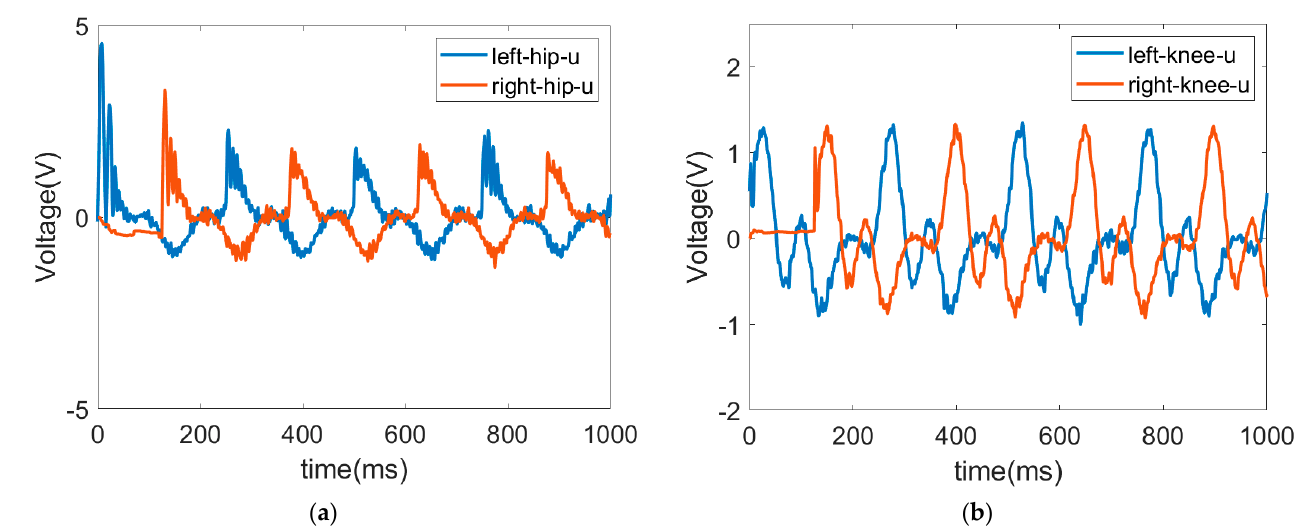
Figure 17. Control signals of hip joint and knee joint while ascending. ( a ) Control signal of hip joint. ( b ) Control signal of knee joint.